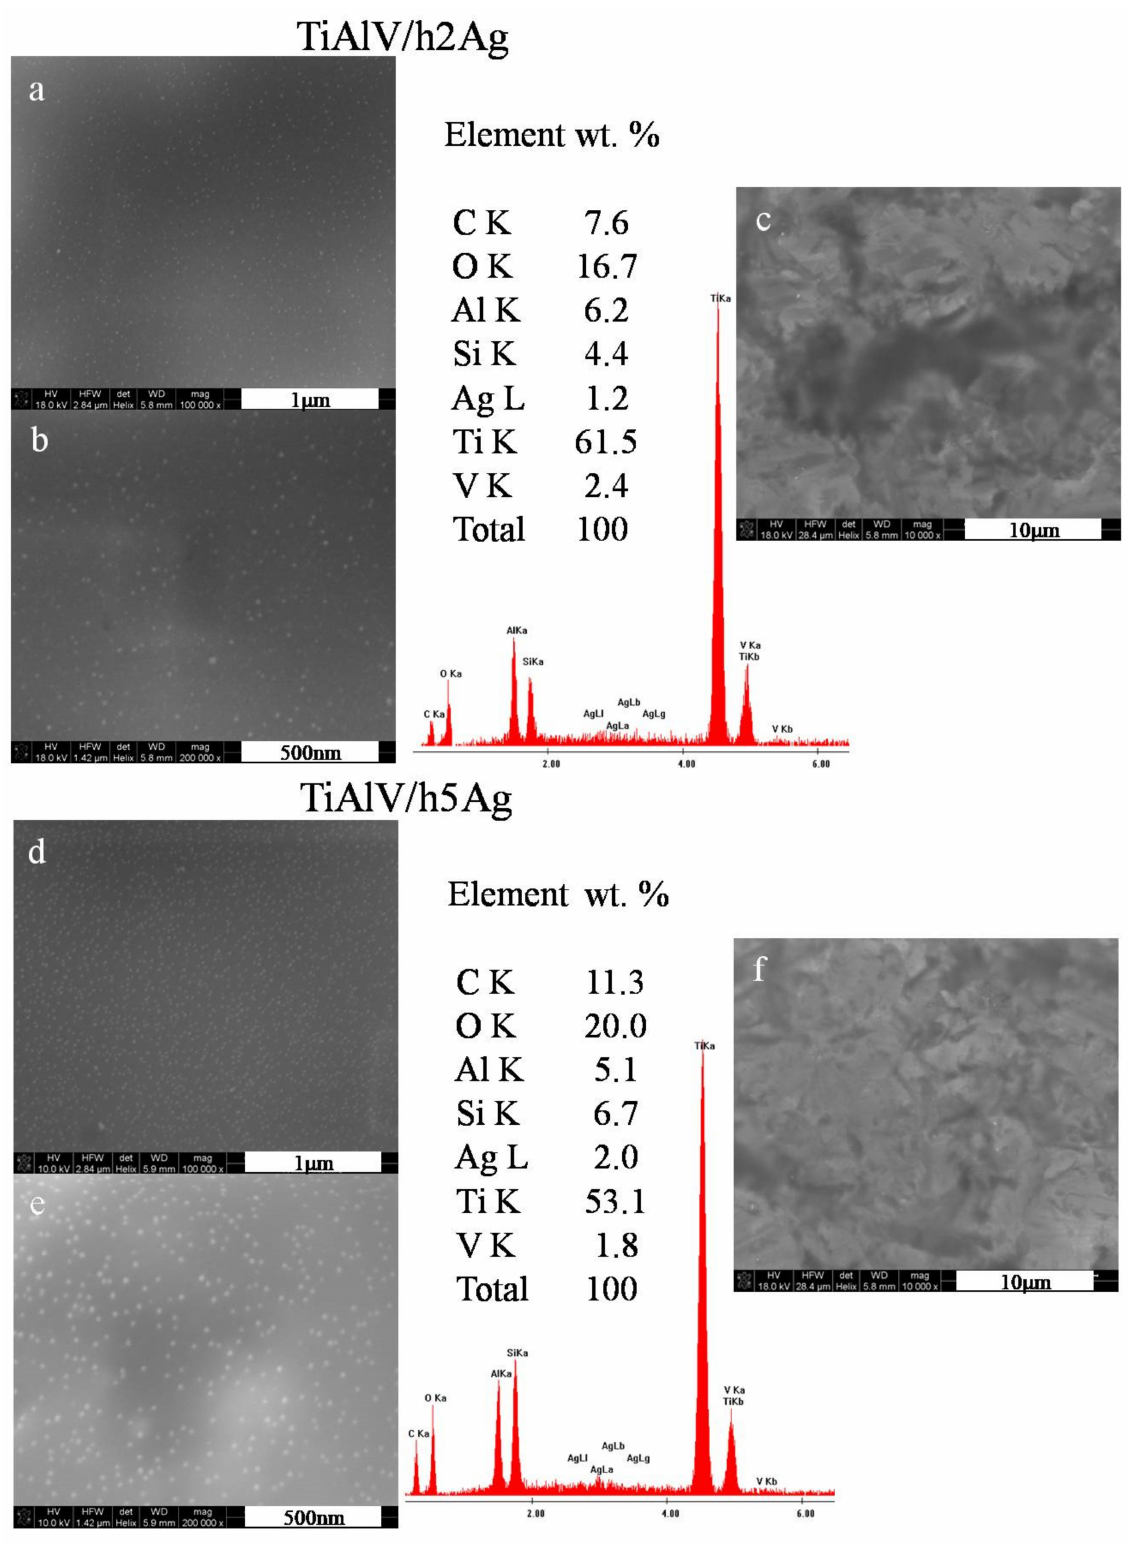
Figure 1. SEM images and EDS spectra of titanium alloy (TiAlV)-covered sol–gel hybrid layer containing silver nanoparticles; ( a – c ) containing 2% AgNPs, and ( d – f ) containing 5%